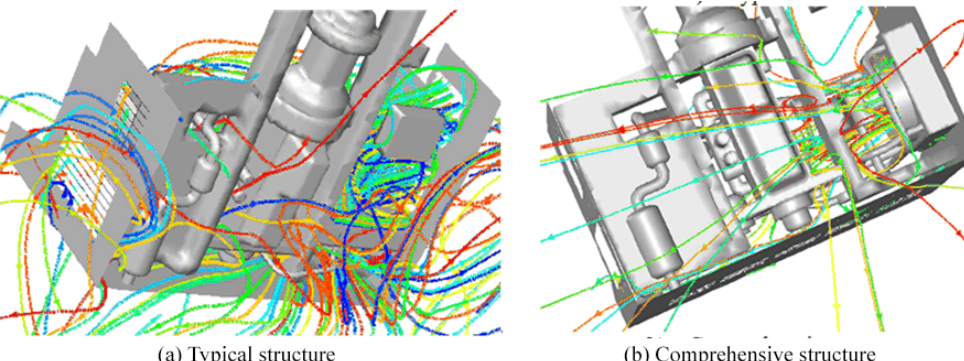
Figure 8. Comparison of air trajectory diagrams (upward